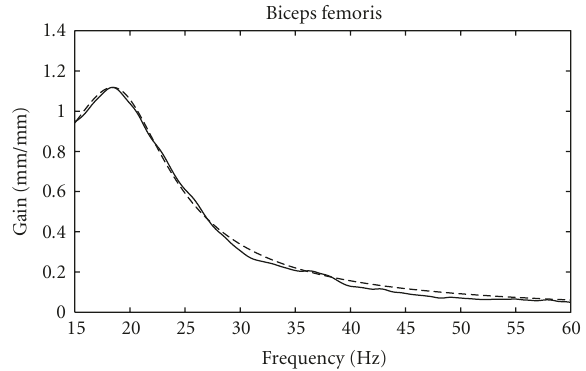
Figure 10: An example of second-order system data fitting: continuous line represent the estimated muscle transfer function while the dotted line shows the second-order approximation.